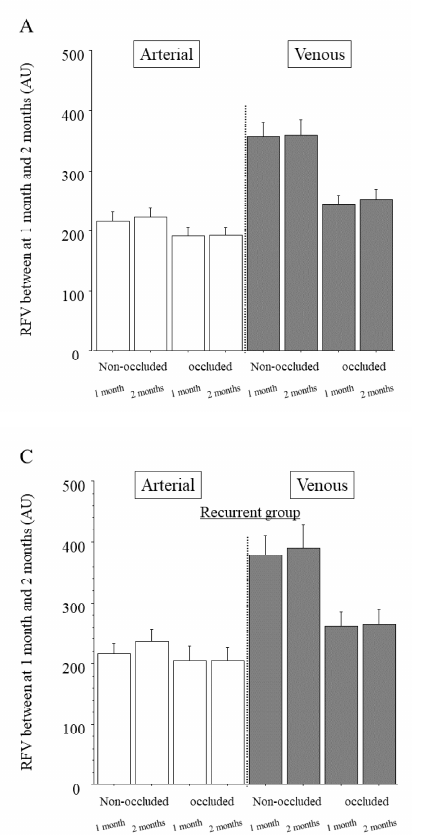
Figure 3. Relative blood volume between the 1 and 2 month time points after intravitreal ranibizumab injection. ( A ) In the whole sample, we found no significant differences in relative flow volume (RFV) between 1 and 2 months after intravitreal ranibizumab injection (IRI) in the arteries of the non- occluded and occluded regions ( p = 0.575, p = 0.908, respectively). We also found no significant differences in RFV between 1 and 2 months after IRI in the veins of the non-occluded and occluded regions ( p = 0.947, p = 0.316, respectively). ( B ) In the group with no recurrence of macular edema (nonrecurrent group, n = 24), we found no significant differences in RFV between 1 and 2 months after IRI in the arteries and veins of the non-occluded and occluded regions (arteries: p = 0.172, p = 0.996, respectively; veins: p = 0.702, p = 0.784, respectively). ( C ) In the group with recurrent macular edema (recurrent group, n = 23), we found no significant differences in RFV between 1 month (before the first recurrence) and 2 months (time of recurrence) after IRI in the arteries and veins of the non-occluded and occluded regions (arteries: p = 0.736, p = 0.877, respectively; veins: p = 0.777, p = 0.243,